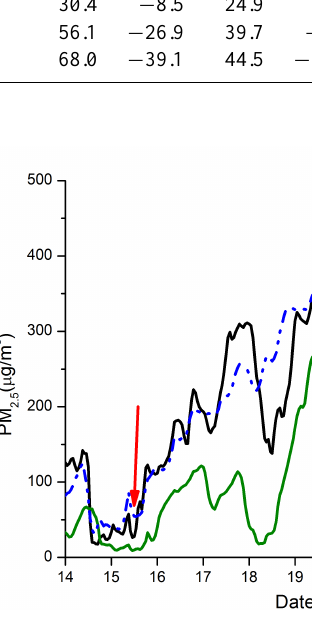
Figure 8. Temporal variations of simulated PM 2 . 5 at Shijiazhuang, Beijing and